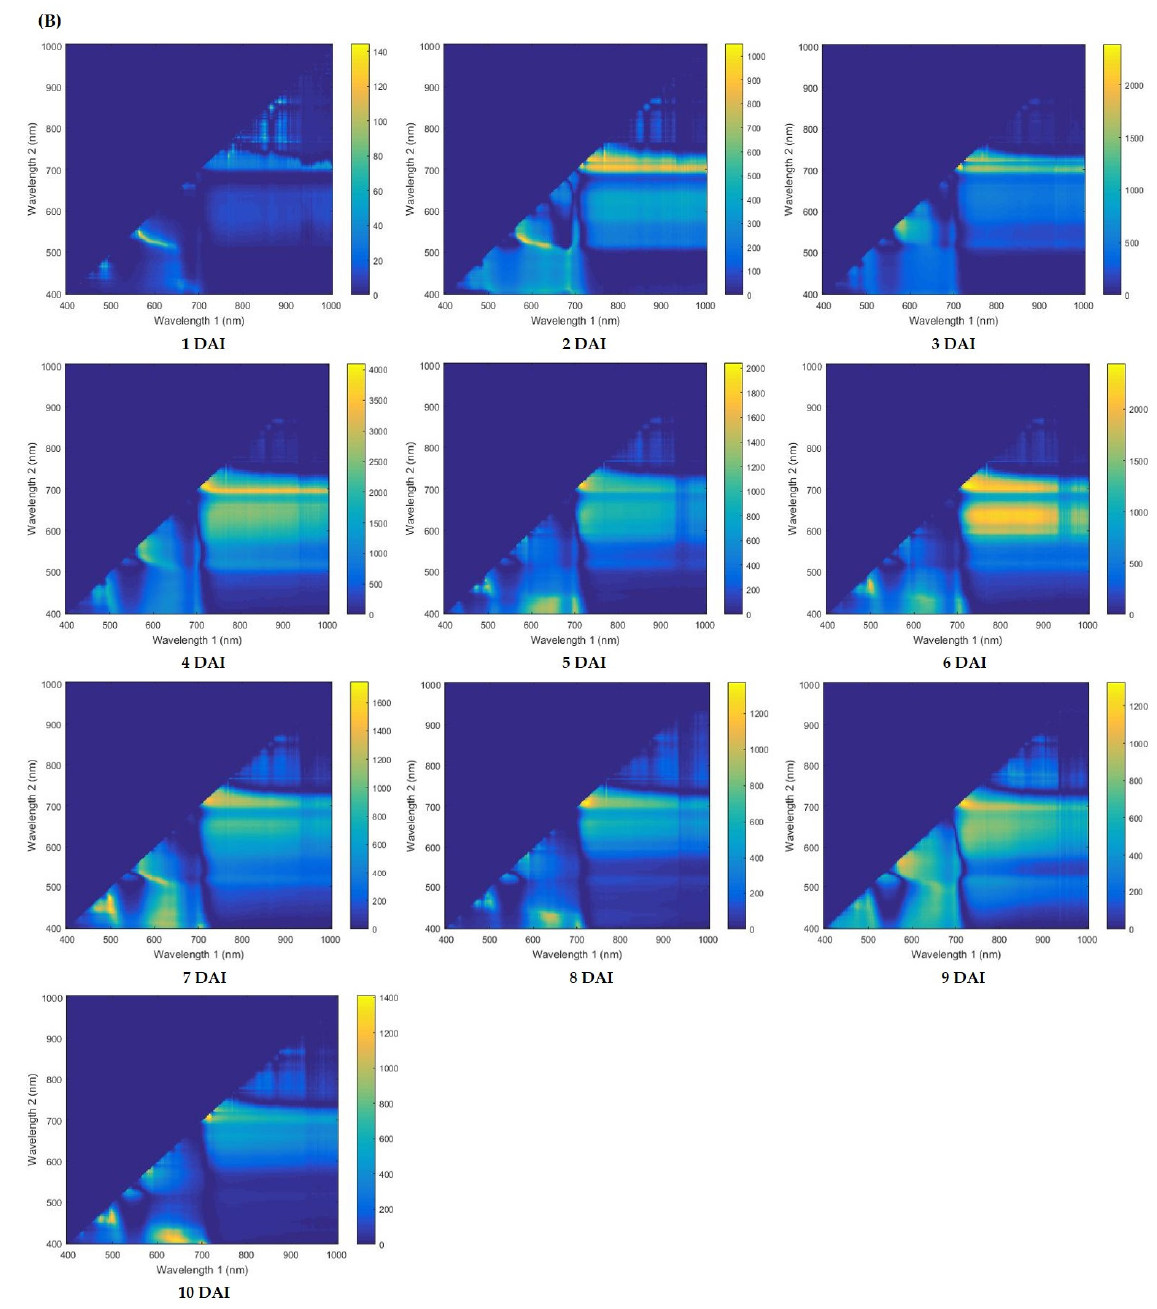
Figure 1. Heatmap obtained from the Python 3.9 analysis algorithm shows the difference in the wavelength between the control and diseased soybean varieties, ( A ) Cheongja 3-ho and ( B ) Daechan, respectively.